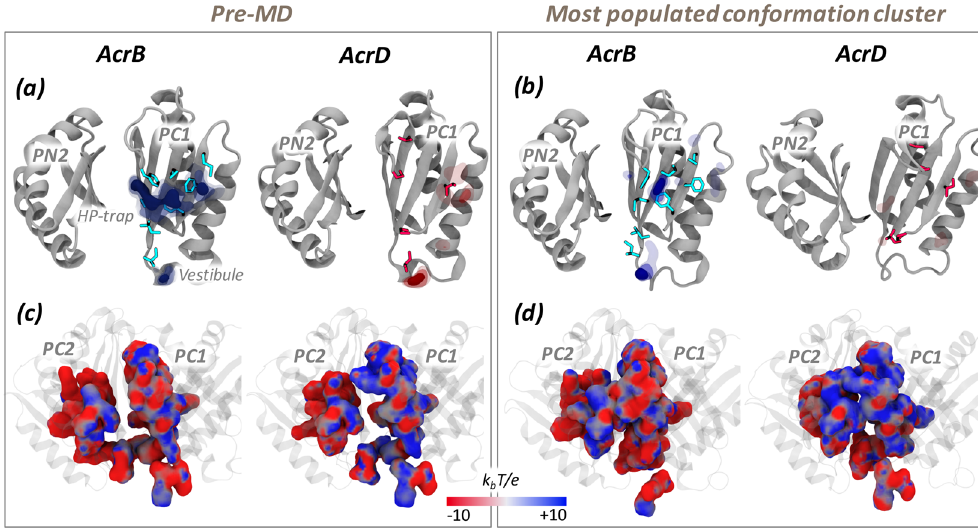
Figure 4. MLP and electrostatic potential of AP in the Loose protomer of AcrB and AcrD. MLP isosurfaces observed within 4 Å of AP in the Loose protomer of AcrB (blue) and AcrD (red) in pre-MD ( a ) and the representatives of the most populated cluster ( b ) as seen from the centre of the protomer. The hydrophobic/ aromatic residues in the AP are shown as sticks in the structures. Isosurfaces at 0.75 (solid), 0.5 (dark transparent) and 0.25 (light transparent) are shown in blue (AcrB) or red (AcrD). The HP-trap and Vestibule sites are also labeled in the pre-MD structure of AcrB. The electrostatic potential plotted on the molecular surface representation of AP in the Acr proteins in the pre-MD ( c ) and the most populated cluster representative ( d ) as seen from the periplasmic front of the protomer. The colour code is red to blue from negative ( − 10 k b T/e) to positive ( + 10 k b T/e) potential, where k b is the Boltzmann constant, T is the absolute temperature and e is the electron charge.